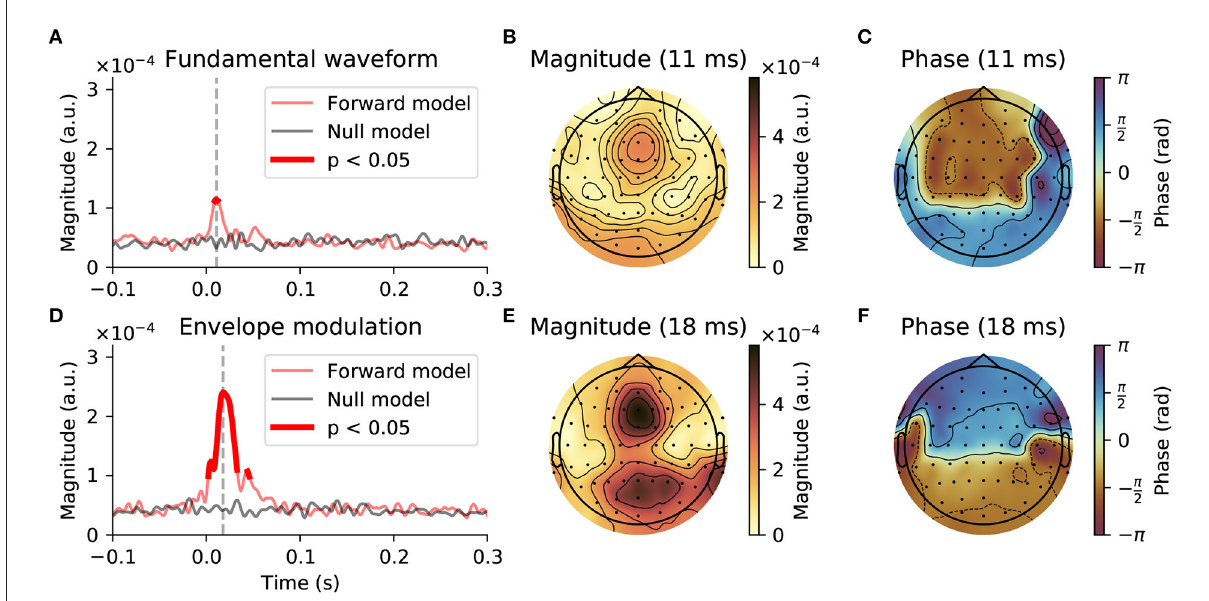
FIGURE3 Early neural response at the fundamental frequency of continuous speech. (A–C) , Response to the fundamental waveform. (A) , The magnitude of the complex coefficients of the forward model (red), averaged across EEG channels and subjects exhibited a peak at an early latency of 11 ms (gray dashed line). The comparison of the complex TRF magnitudes to a null model (black solid line) showed that significant responses emerge only at latencies around the peak latency, between 9 and 12 ms (thicker red line, p < 0.05 , corrected for multiple comparisons). (B) , At the peak latency of 11 ms, the largest contribution to the TRF came from central-frontal and occipital areas, as well as from the mastoid electrodes. (C) , The phase of the model coefficients indicated a phase shift of approximately π between the frontal area on the one hand and the occipital and mastoid electrodes on the other hand. (D–F) , Neural response to the high-frequency envelope modulation. (D) , The average magnitude of the complex TRF coefficients was substantially larger than that of the response to the fundamental waveform. In particular, the coefficients of the model significantly exceeded the chance level between 2 and 33 ms and 44 ms to 46 ms, with the peak magnitude at 18 ms. (E,F) , At the peak latency of 18 ms the TRFs exhibited similar topographic patterns to those obtained for the response to the fundamental